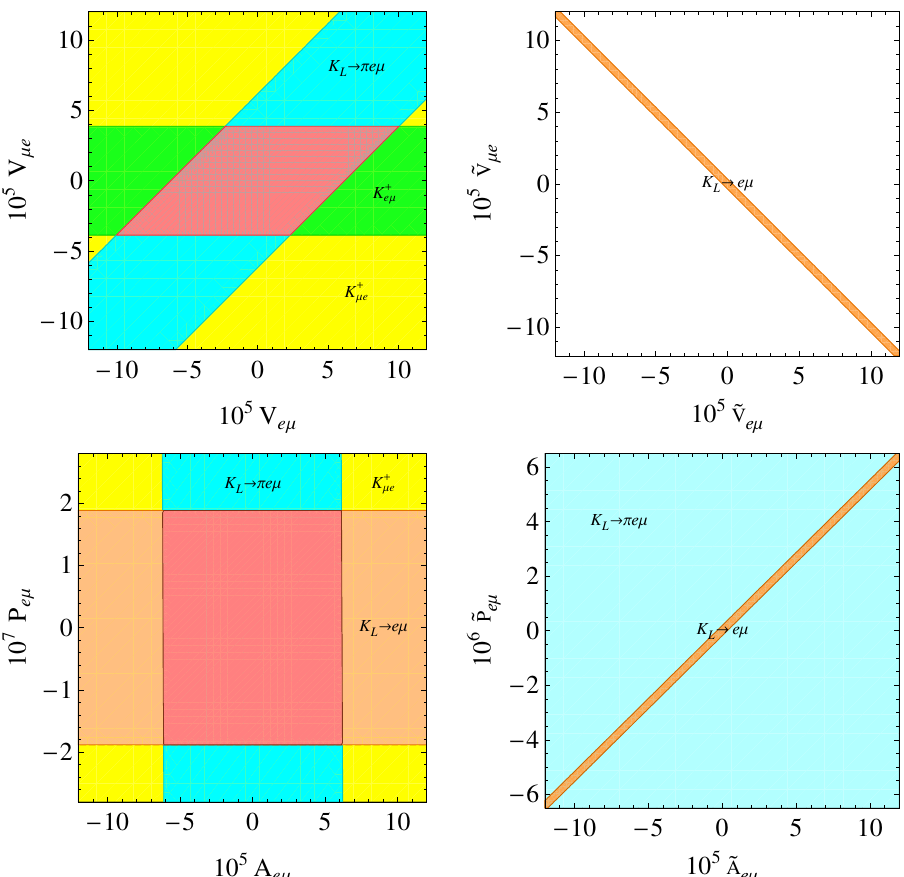
Figure 1 . Regions of V versus V (top left), ˜ v versus ˜ v (top right), P versus A (bottom µe eµ µe eµ eµ eµ versus ˜ a (bottom right), all taken to be real, for Λ np = 1 TeV, allowed by the left), and ˜ p eµ eµ 0 e , K + experimental limits on the branching-fractions of K π + e − µ + , K + π + µ − e + , ± µ ∓ L → π → → (cid:31) , K + , K + , and K , respectively). In the left indicated by K and K L → e ± µ ∓ L → πeµ L → eµ eµ µe (cid:31) (cid:30) is included because they (right) plot at the bottom, the bound from K πe ± µ ∓ K L L → e ± µ ∓ → (cid:30) (cid:31) ˜ p , from eq. (1.7). In each of the four cases, all the other = are affected by ˜ s P eµ S eµ = eµ eµ − − couplings are set to